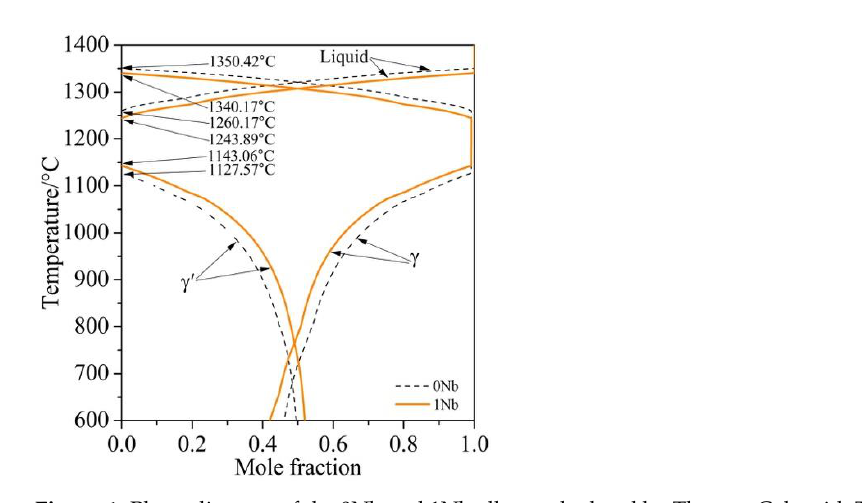
Figure 1. Phase diagram of the 0Nb and 1Nb alloys calculated by Thermo-Calc with TTNI8